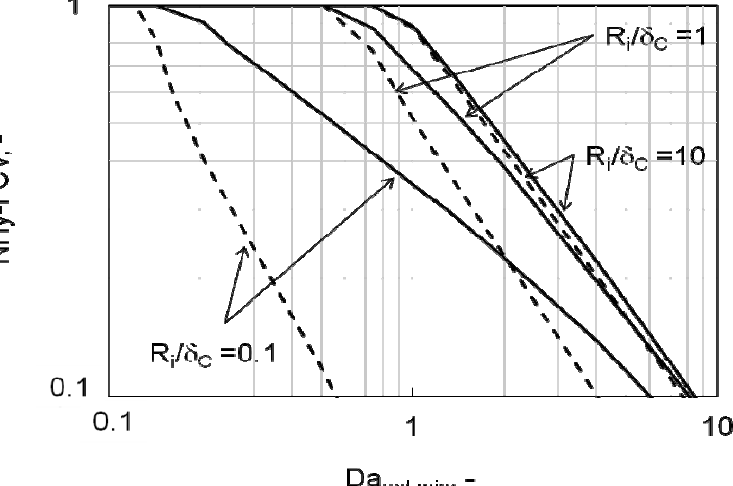
Figure 6. Model-predicted dependence on Da cylindrical constructs featuring varying wall curvature, R perfused with medium outwards ( γ = 1, solid lines), or inwards ( γ = − 1, dashed